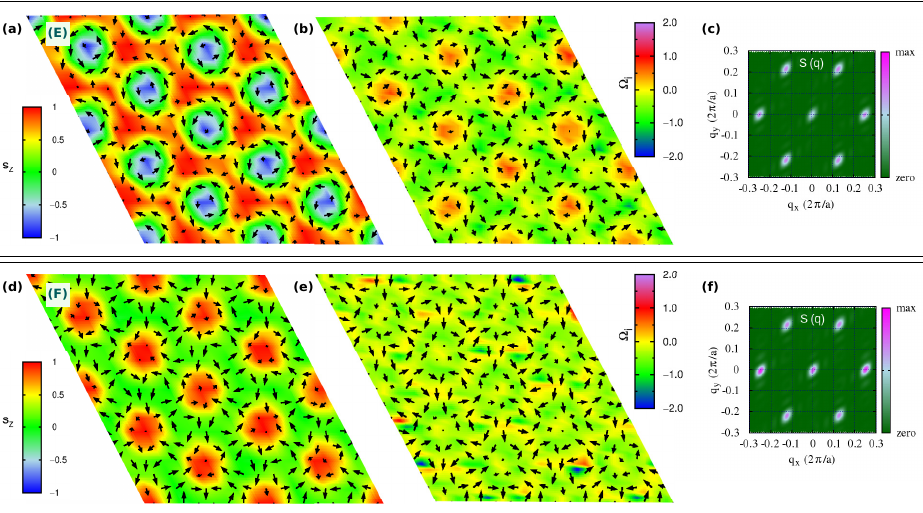
Figure 4. Topological lattices with | Q | m . u . c = 3. Similarly to Figure 3, snapshots at T = 1 K of real-space spin configurations ( a , d ) and topological charge densities Ω i ( b , e ), for the field-induced triple-( q ) states: E-phase, consisting of a Bloch-type skyrmions (SK) lattice; F-phase consisting of a anti-bi-merons (A2M) lattice. The peak at q = 0 in the S ( q ) reflects the ferromagnetic component induced by the applied B z ( c , f